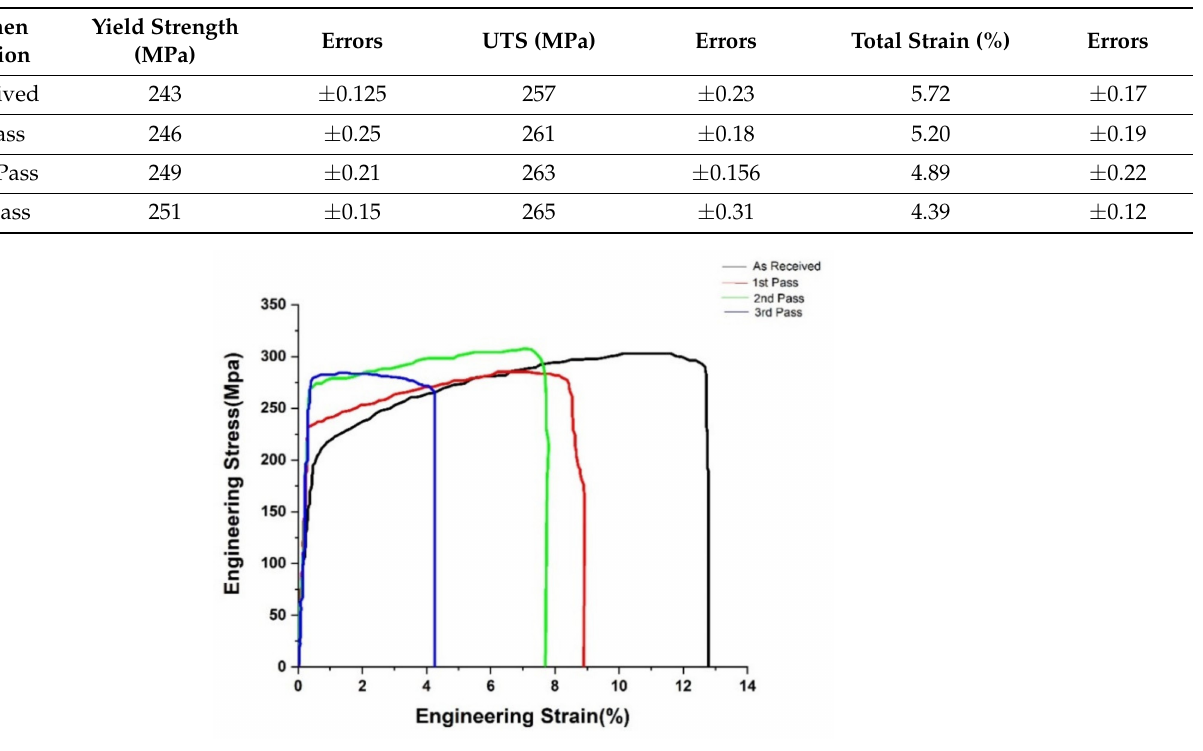
Figure 6. The tensile curve of Al 5083 alloy in 10 − 3 /s strain rates in ambient temperature. The no-pass sample, i.e., the as-received alloy, exhibited the yield strength (YS), and ultimate tensile strength (UTS) was 243 MPa and 257 MPa with an elongation of 5.72%.